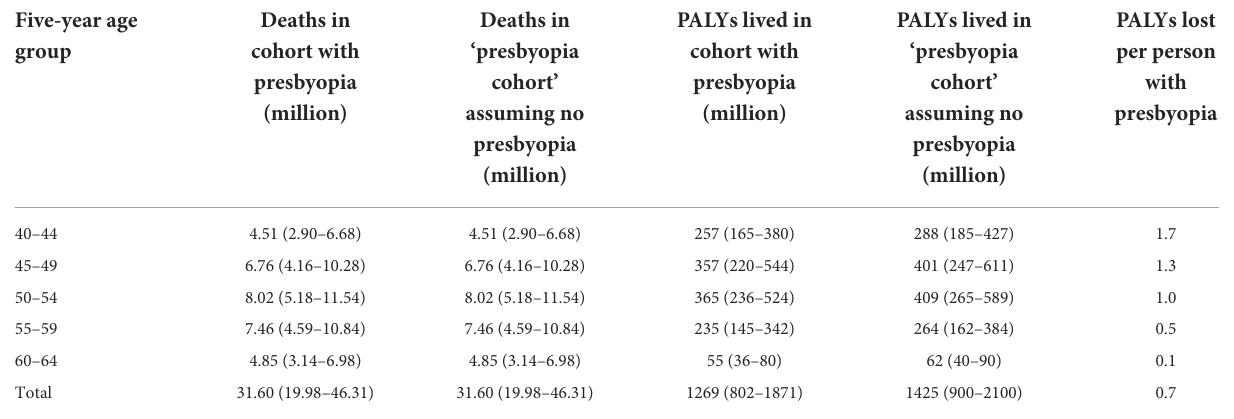
TABLE 2 Years of life lived in those with presbyopia, and in the same cohort assuming no presbyopia, over the working lifetime of the population simulated from life table